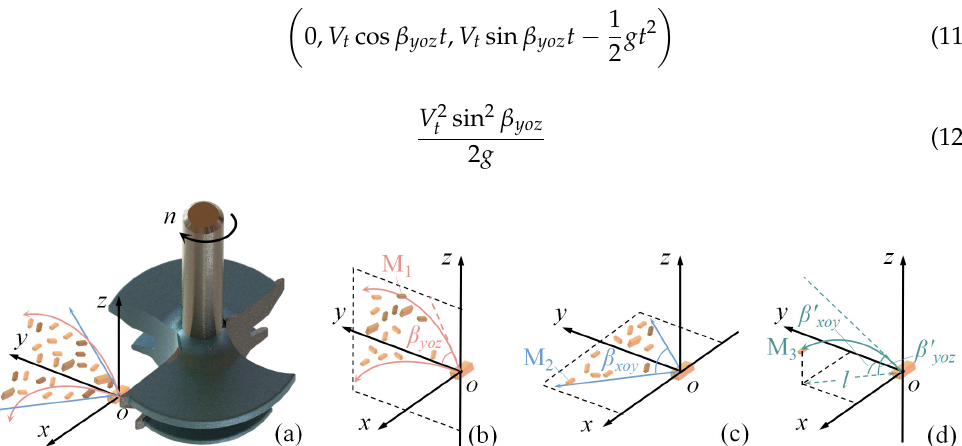
Figure 4. Boundary of the wood chip diffusion surface. ( a ) The boundary trajectory after the chip is detached from the milling cutter. ( b ) The boundary in the yoz plane. M 1 is the wood chip on the boundary line of this plane. β yoz is the initial angle of the wood chip boundary in the yoz plane and the maximum angle. ( c ) The boundary in the xoy plane. M 2 is the wood chip on the boundary line of this plane. β xoy is the initial angle of the wood chip boundary in the xoy plane and the maximum angle. ( d ) For any chip M 3 located on the boundary surface, the angles β ’ yoz and β ’ xoy represent the inclination of the initial velocity with respect to the xoy plane and the current plane with respect to the yoz plane,